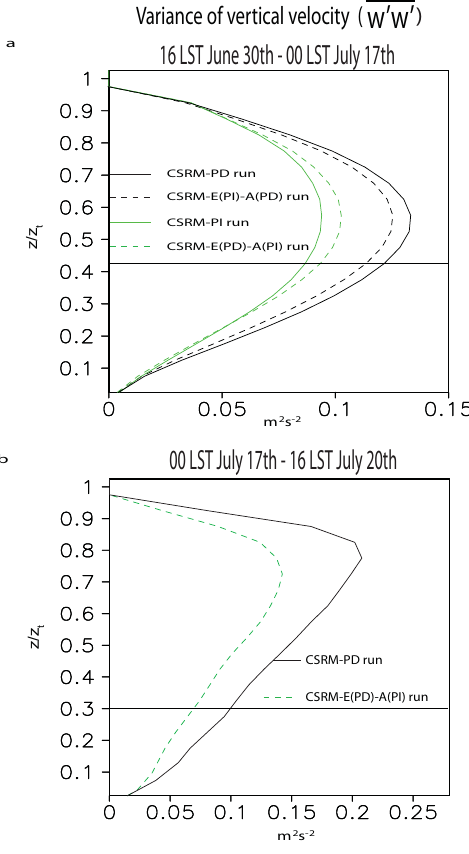
Fig. 11. Vertical distribution of the time- and area-averaged vari- ance of vertical velocity ( w 0 w 0 ) (m − 2 s − 2 ) (a) for all of the CSRM runs and (b) for the CSRM-PD run and the CSRM-E(PD)-A(PI) run. (a) and (b) are averaged over 16:00LST on 30 June–00:00LST on 17 July and over 00:00LST on 17 July–16:00LST on 20 July, respectively. The solid horizontal line in each figure is the average cloud-base height normalized with respect to cloud-top height ( z t )